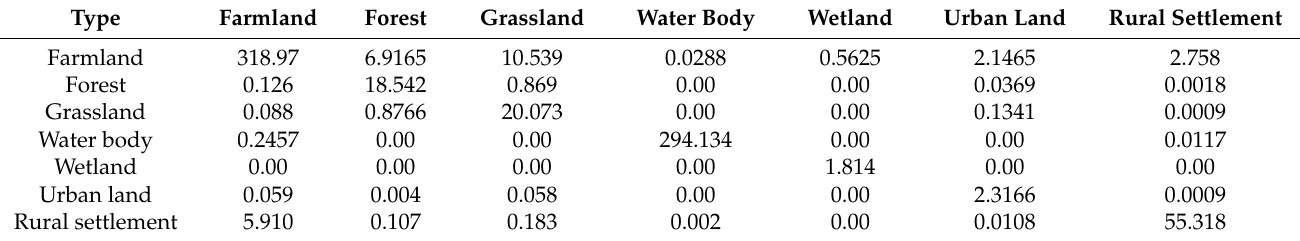
Table 7. Land use transfer matrix under TD scenario (km 2